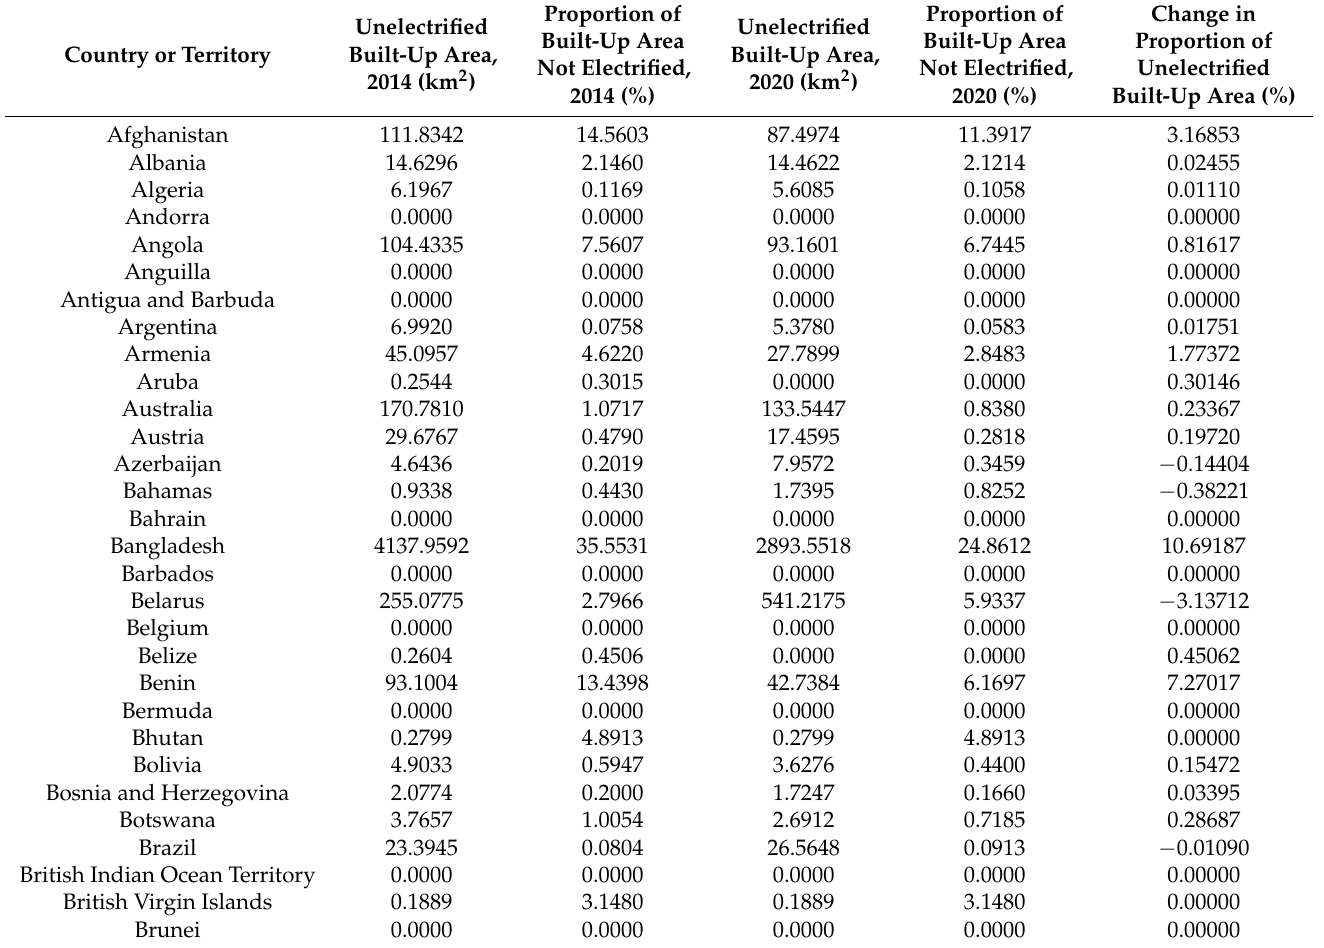
Table A1. Identification of built-up area electrification in each